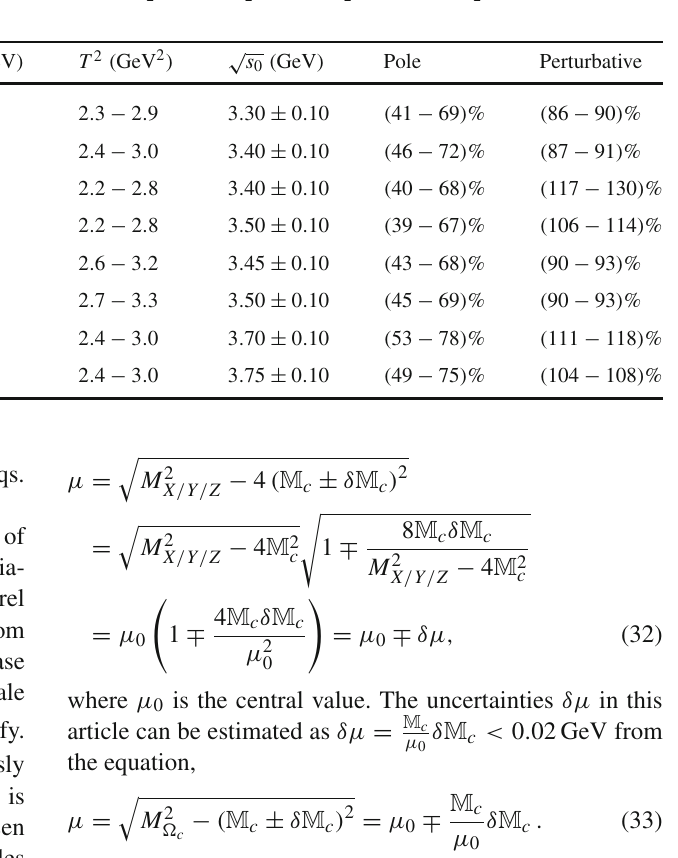
) , (cid:2) ( 1S , 3 ) , (cid:2) ( 1P , 1 ) and (cid:2) ( 1P , 3 ) , respectively c c c 2 2 2 2